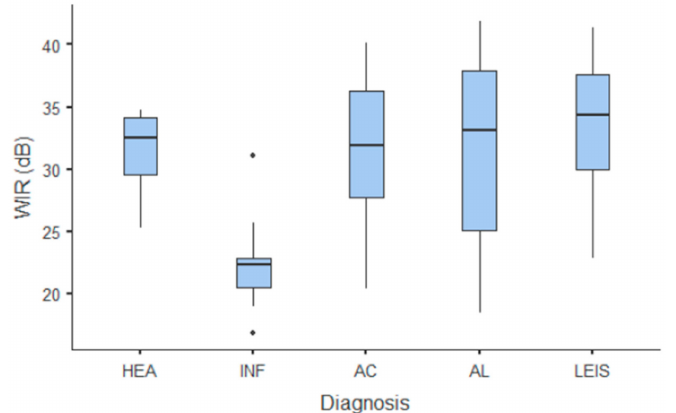
Figure 8. Box and whisker plot of the wash-in rate (WiR) for healthy (HEA), inflammatory (INF), adenocarcinoma (AC), lymphoma (AL), and leiomyosarcoma (LEIS).